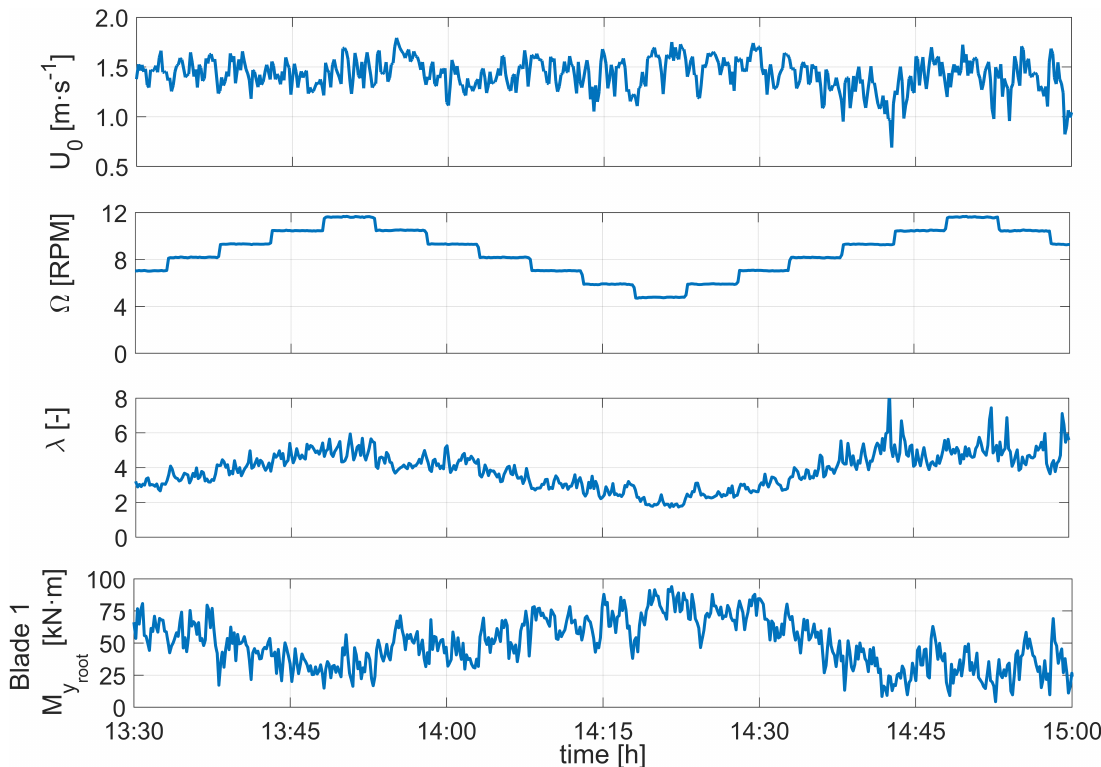
Figure 11. Time-series of approach flow velocity ( U 0 ), turbine rotational speed ( Ω ), tip speed ratio ( λ ) and blade 1 root bending moment ( M y ) during a test that took place in an ebb root